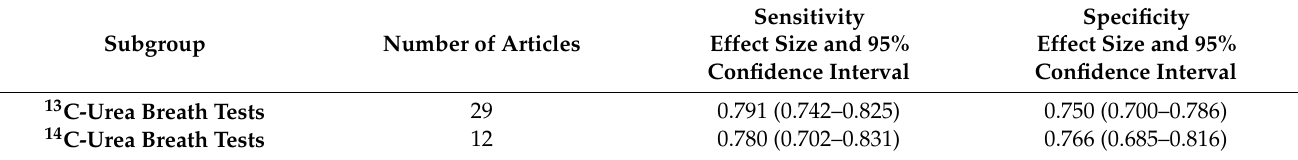
Table 5. Subgroup